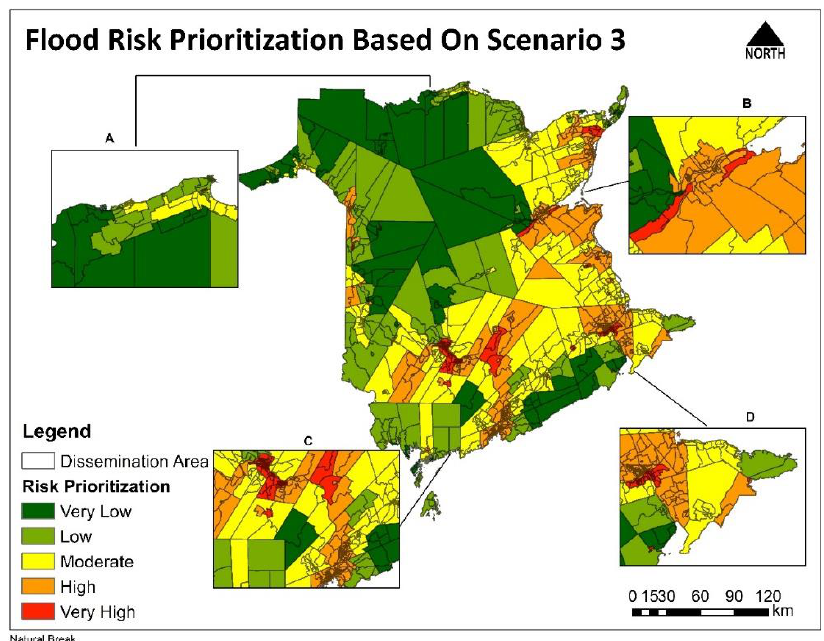
Figure 7. Flood risk prioritization based on scenario 3 using zonal statistics.